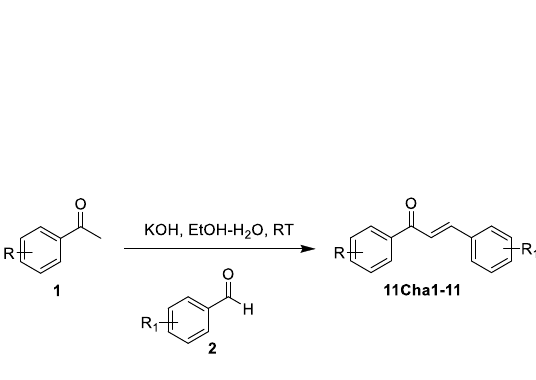
Figure A1. General procedure for the synthesis of compound 11Cha1–11.